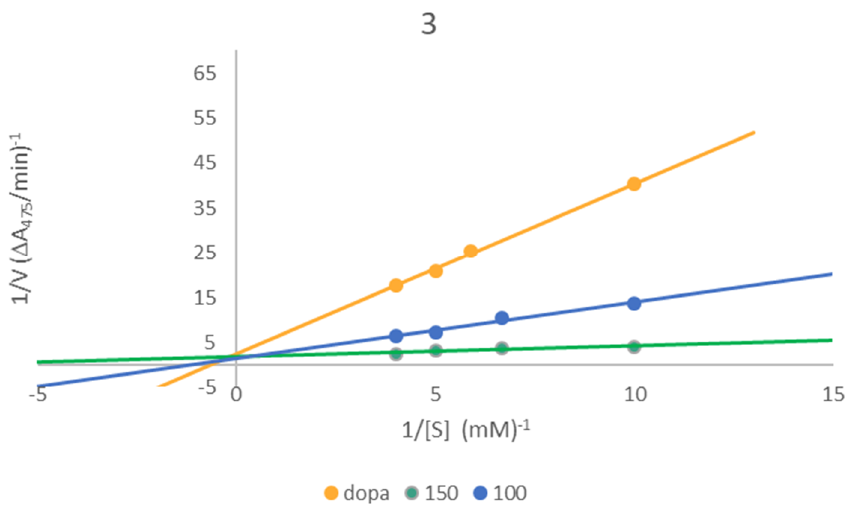
Figure 1. Lineweaver–Burk plots for tyrosinase inhibition for compounds 3 at concentration 0.2 mM using L-DOPA as substrate at concentrations 0.1, 0.15, 0.20 and 0.25 mM. The low value of the inhibition constant, K m 0.8048, indicates the strong inhibition of tyrosinase by this compound.